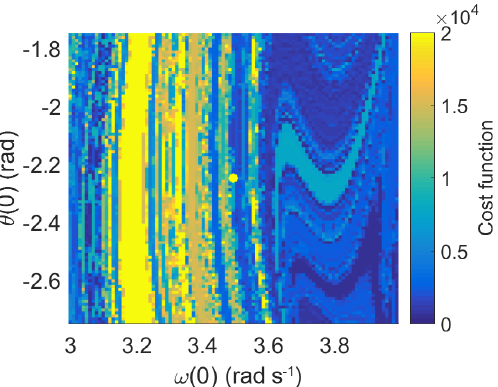
Figure 2. Cost-function values as a function of initial angle, θ , and angular velocity, ω , for an observational time window of 50s. The local minimum found by the optimization (yellow dot) is not the absolute minimum value of the cost function.